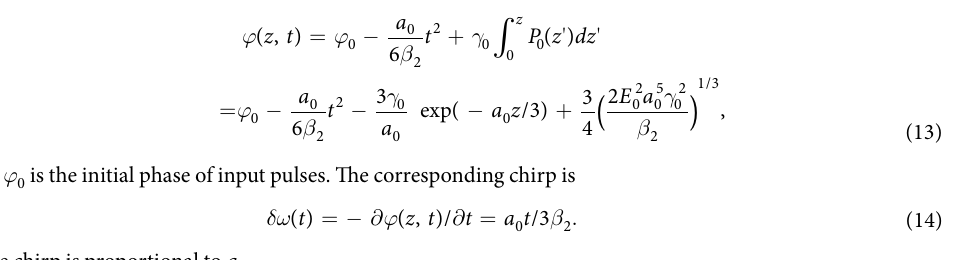
The chirp is proportional to a 0 .